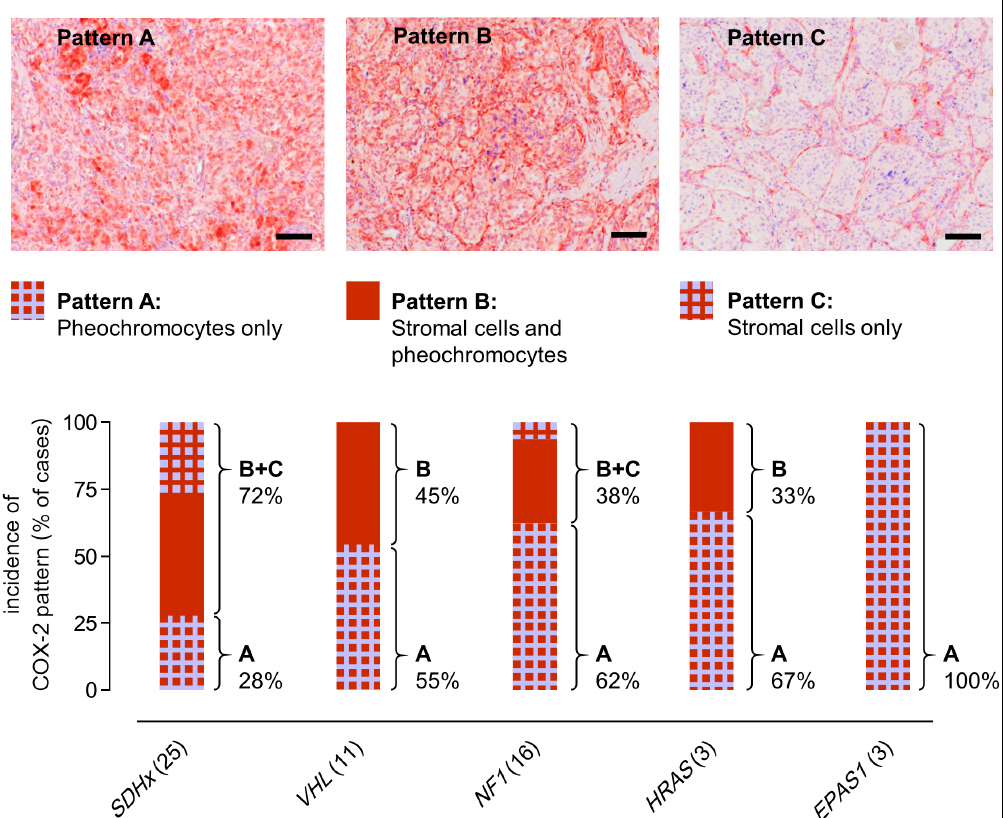
Figure 4. Immunoreactivity pattern in COX-2-positive PPGLs; COX-2 immunoreactivity with stromal cells involved was more frequently observed in tumors related to SDHx mutations (72%, pattern B + C) compared to other genetic background (0 − 45%); histologic examples: (pattern A) HRAS somatic mutation; (pattern B) SDHD germline mutation; (pattern C) SDHD germline mutation; see Table S1 for statistical analyses; scale bars: 0.1 mm.